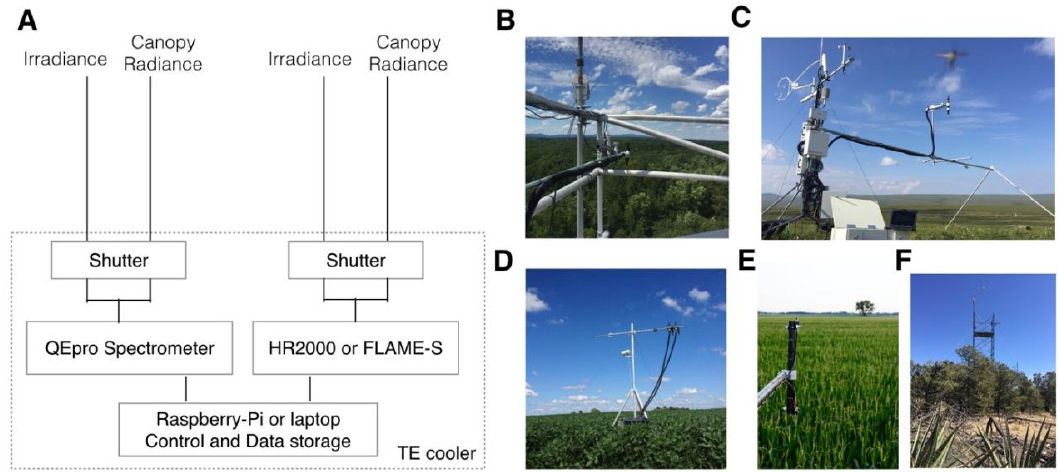
Figure 1. The design of FluoSpec 2. ( A ) An example of the system with both a solar-induced chlorophyll fluorescence (SIF) spectrometer and a reflectance spectrometer; ( B ) FluoSpec 2 on a 40-m tower in central Virginia; ( C ) Alaska site with FluoSpec 2; ( D ) FluoSpec 2 in a crop field in Illinois, and ( E ) Nebraska; ( F ) New Mexico.